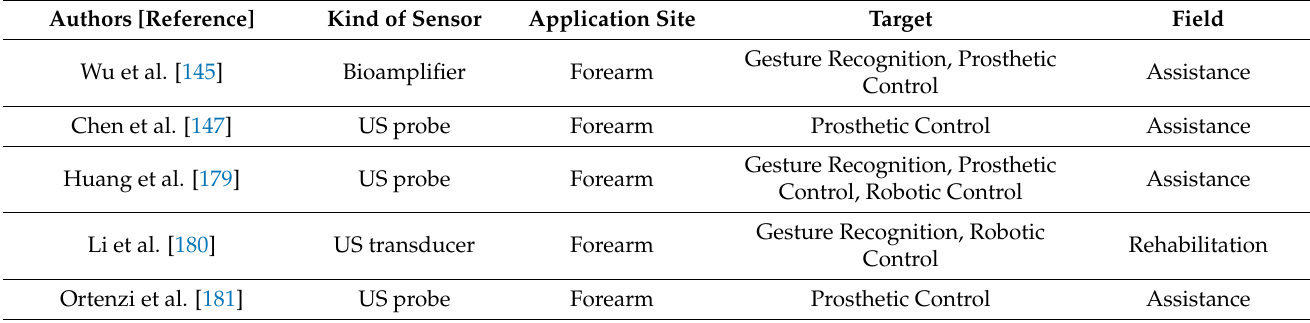
Table 9. Muscle–tendons movement-based